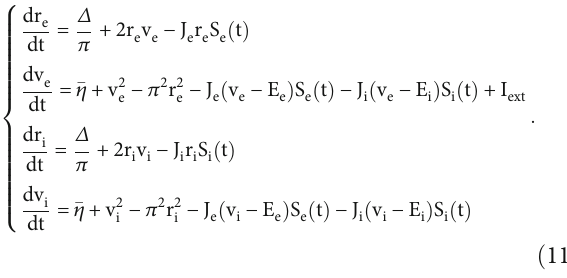
Figure 3: Two single-parameter bifurcation diagrams with respect to I represent the stable equilibria, and the black dashed lines give the unstable equilibria. The purple solid lines and the green solid lines represent the maxima and minima of the stable limit cycles. The blue dashed lines identify the maxima and minima of the unstable limit cycles. The orange circles indicate the Hopf bifurcation